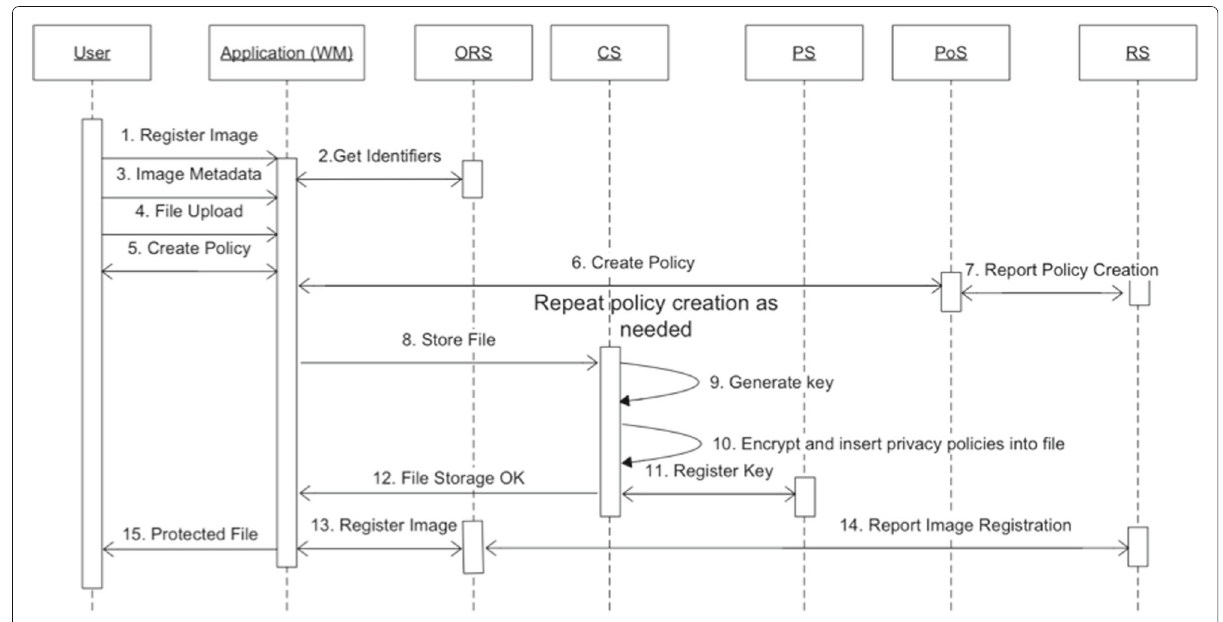
Fig. 7 Image protection